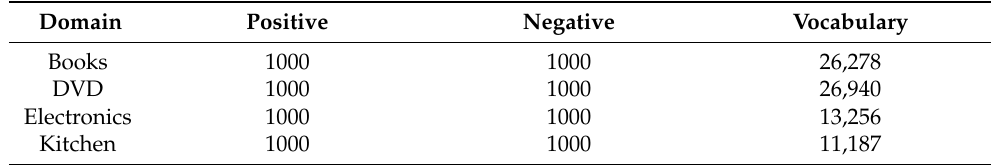
Table 1. Statistics of Dataset 1.